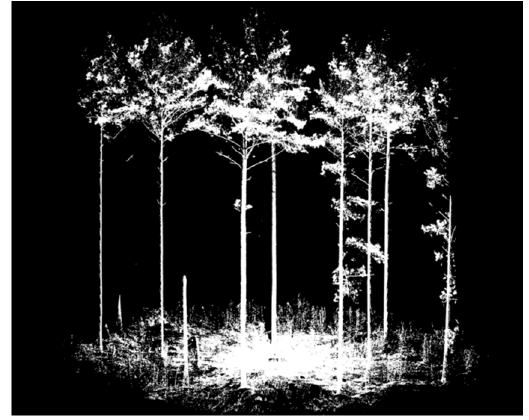
Figure 10. TLS data imported into 3D Forest prior to segmentation.